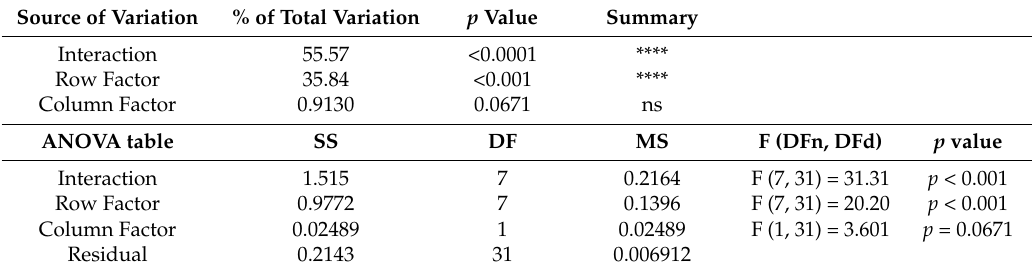
Table A1. Summary statistics resulting from the two-way ANOVA performed on the activation data presented in Figure 1. This analysis was performed in Graphpad Prism